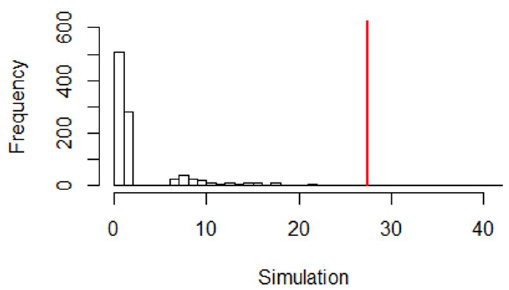
Figure D4. RMS simulation ratios in relation to the observed ratio (red) at 40–50cm depth.